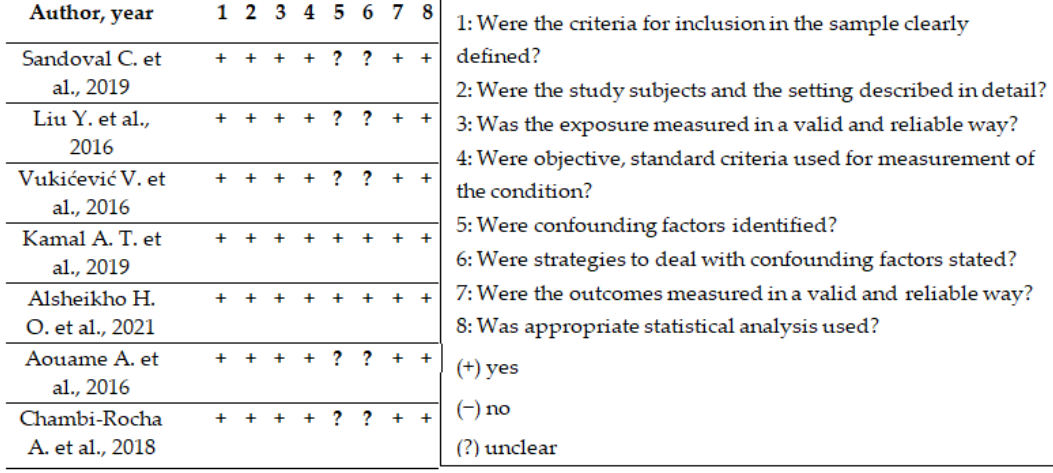
Figure 2. Summary assessment of the risk of bias of the included studies [12,25–30] performed using Joanna Briggs Institute Critical Appraisal Checklist for Analytical Cross-Sectional Studies.